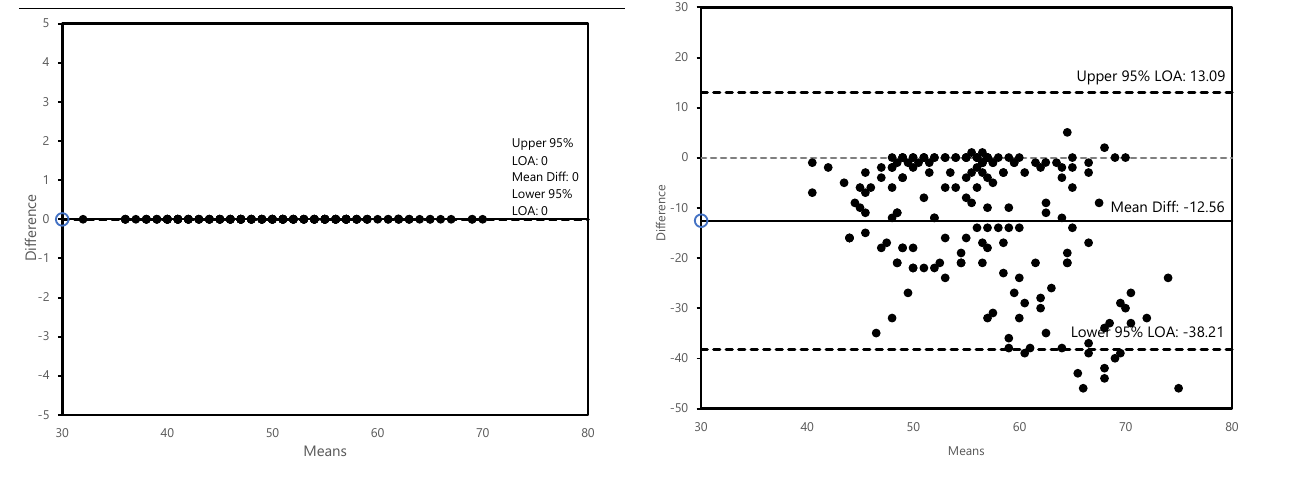
Figure 2 . Bland-Altman Plot for Video 2. Negative Y-axis Values Indicate the 2nd Manual Push Counts Were Greater than the 1st Manual Push Count and Vice-versa.